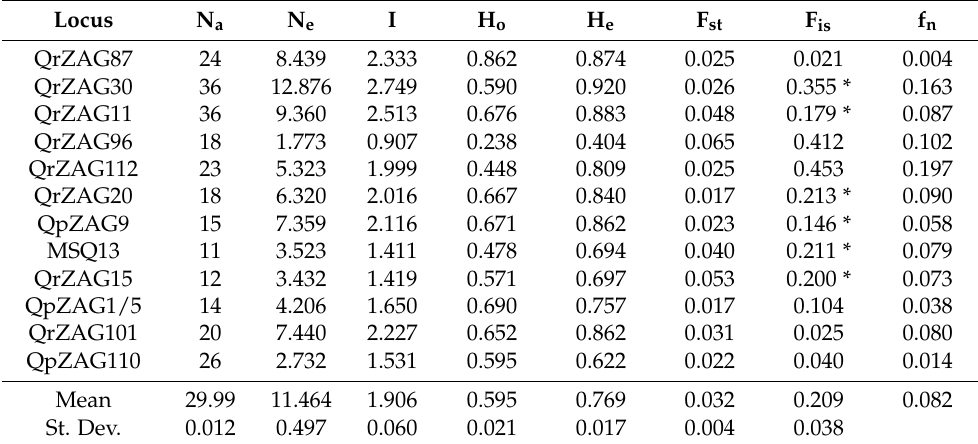
Table 3. Characteristics of twelve SSR loci across seven pedunculate oak populations.